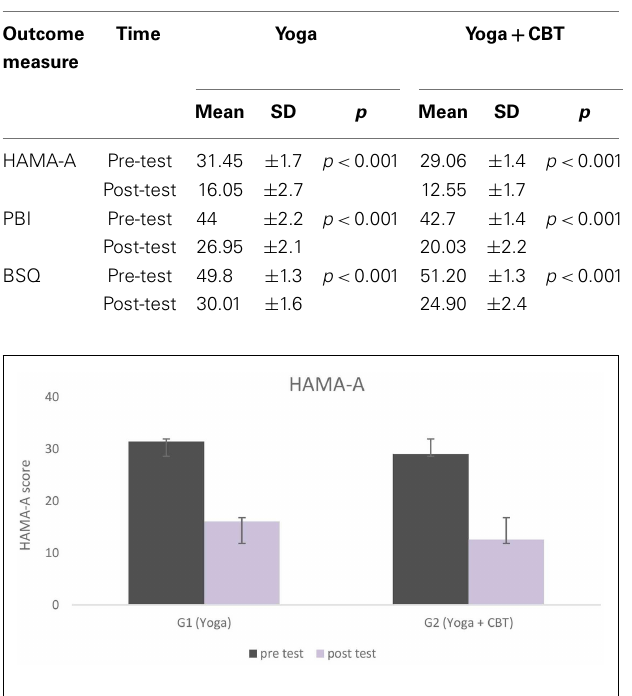
FIGURE 1 | Hamilton anxiety rating scores for both groups, from baseline to end program .